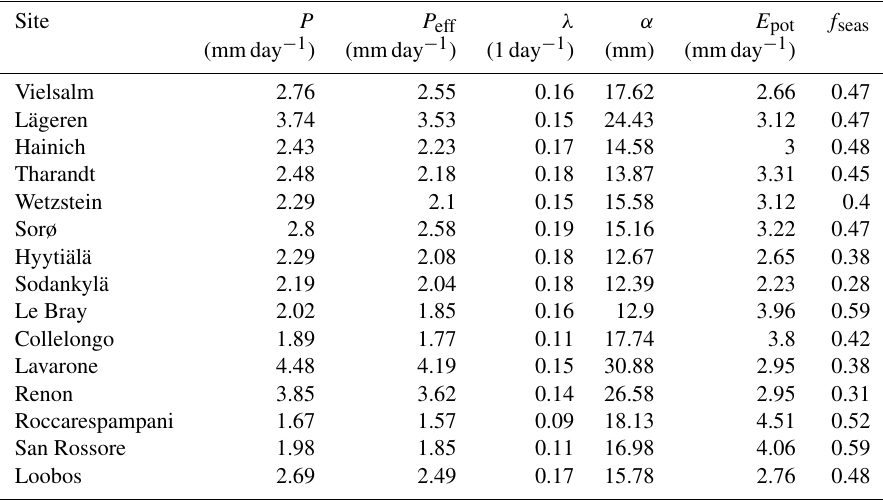
Table 5. Climate parameters, calculated as growing-season averages over the calibration period (see text). Site P P eff λ α E pot f seas (mmday − 1 ) (mmday − 1